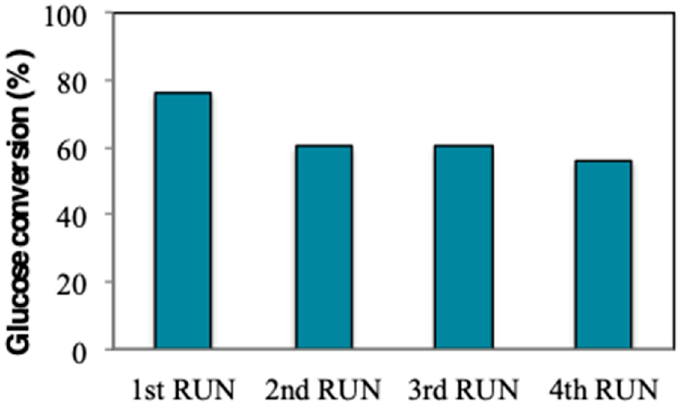
Figure 7. Reusability study over the Au-Mt/Ce catalyst.